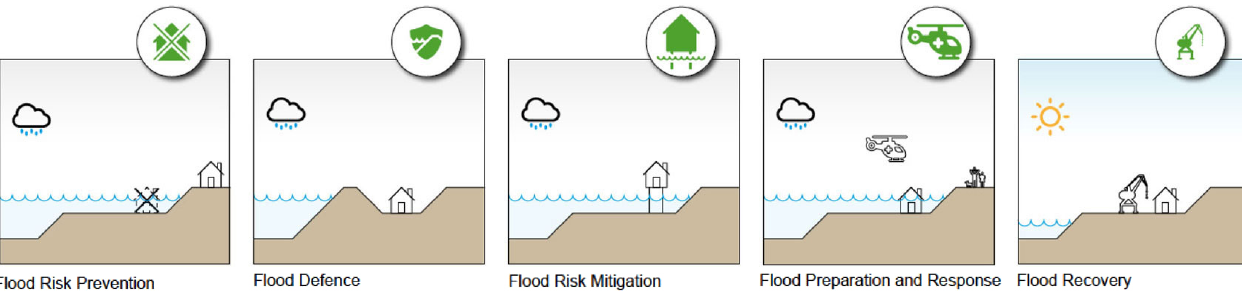
Fig. 2 . Five types of flood risk management strategies (adopted from Hegger et al. 2014 with visualizations taken from Raadgever et al. 2016 and reprinted with